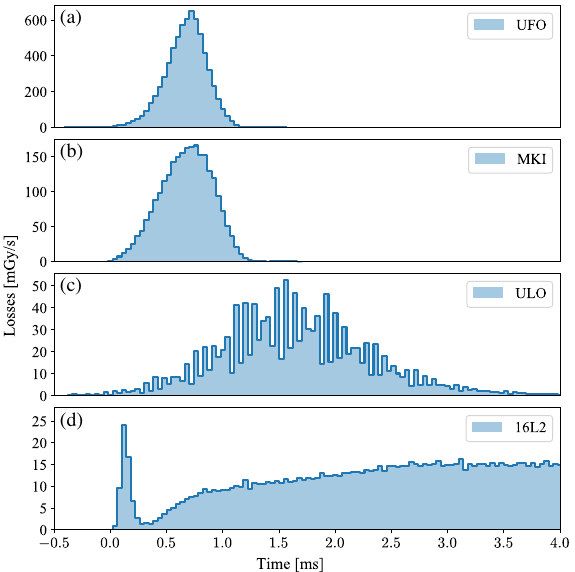
FIG. 1. Comparison of the loss signature of standard UFO losses (a) with three distinctive UFO types, MKI (b), ULO (c) and 16L2 (d), observed during Run